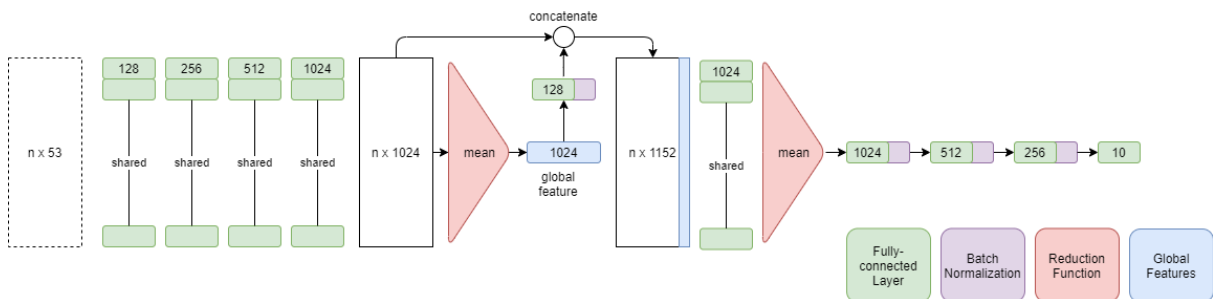
Figure 4. Proposed network architecture for learning to classify the correct label class for a list of multi-view predictions.